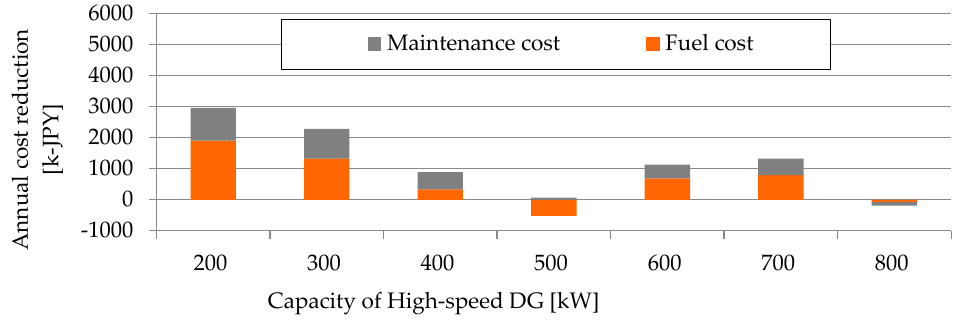
Figure 6. The annual cost reduction effect of operation when connecting a high-speed DG under the conventional method.